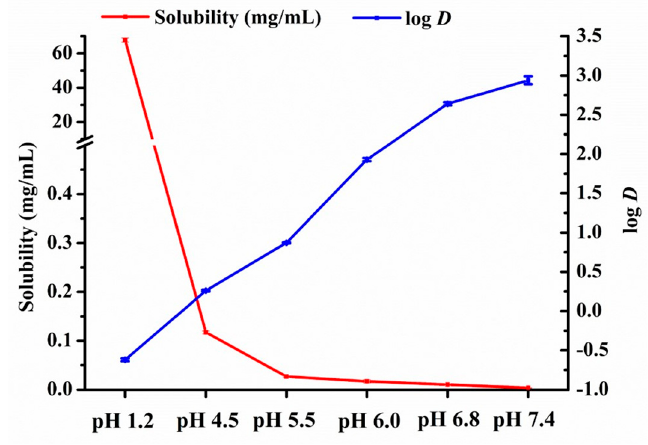
Figure 2. Equilibrium solubility and apparent n–octanol/water partition coefficient for nintedanib in different pH media (mean ± SD, n = 3).